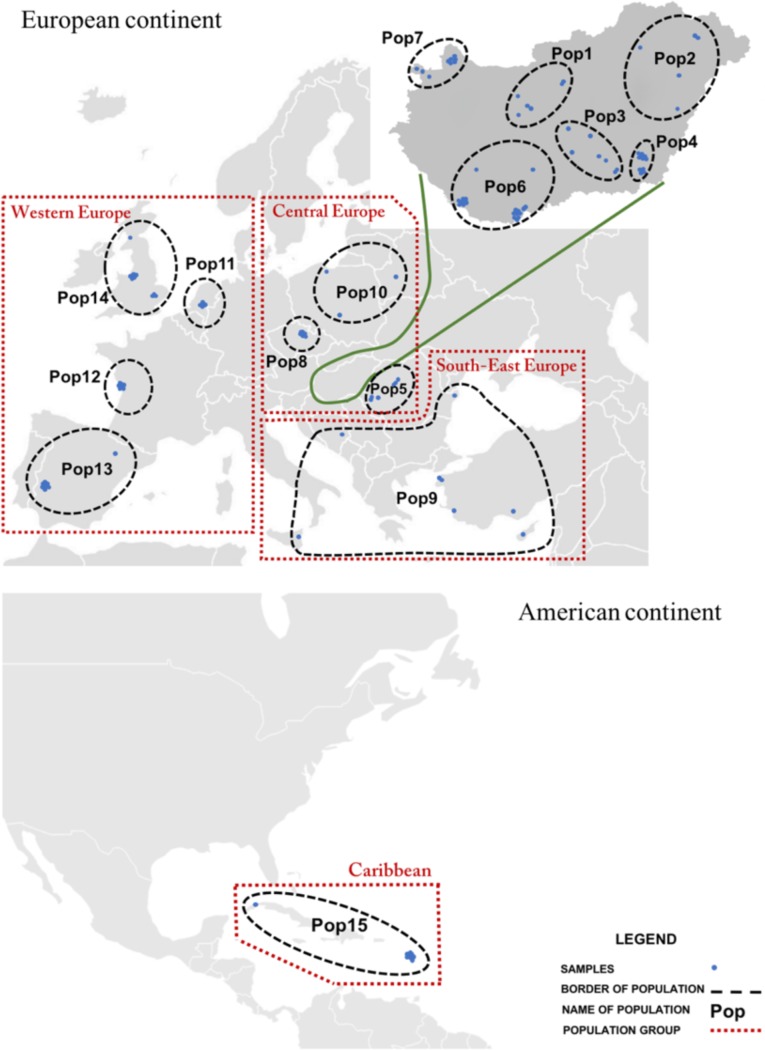
Populations assigned for examination of divergence between populations.